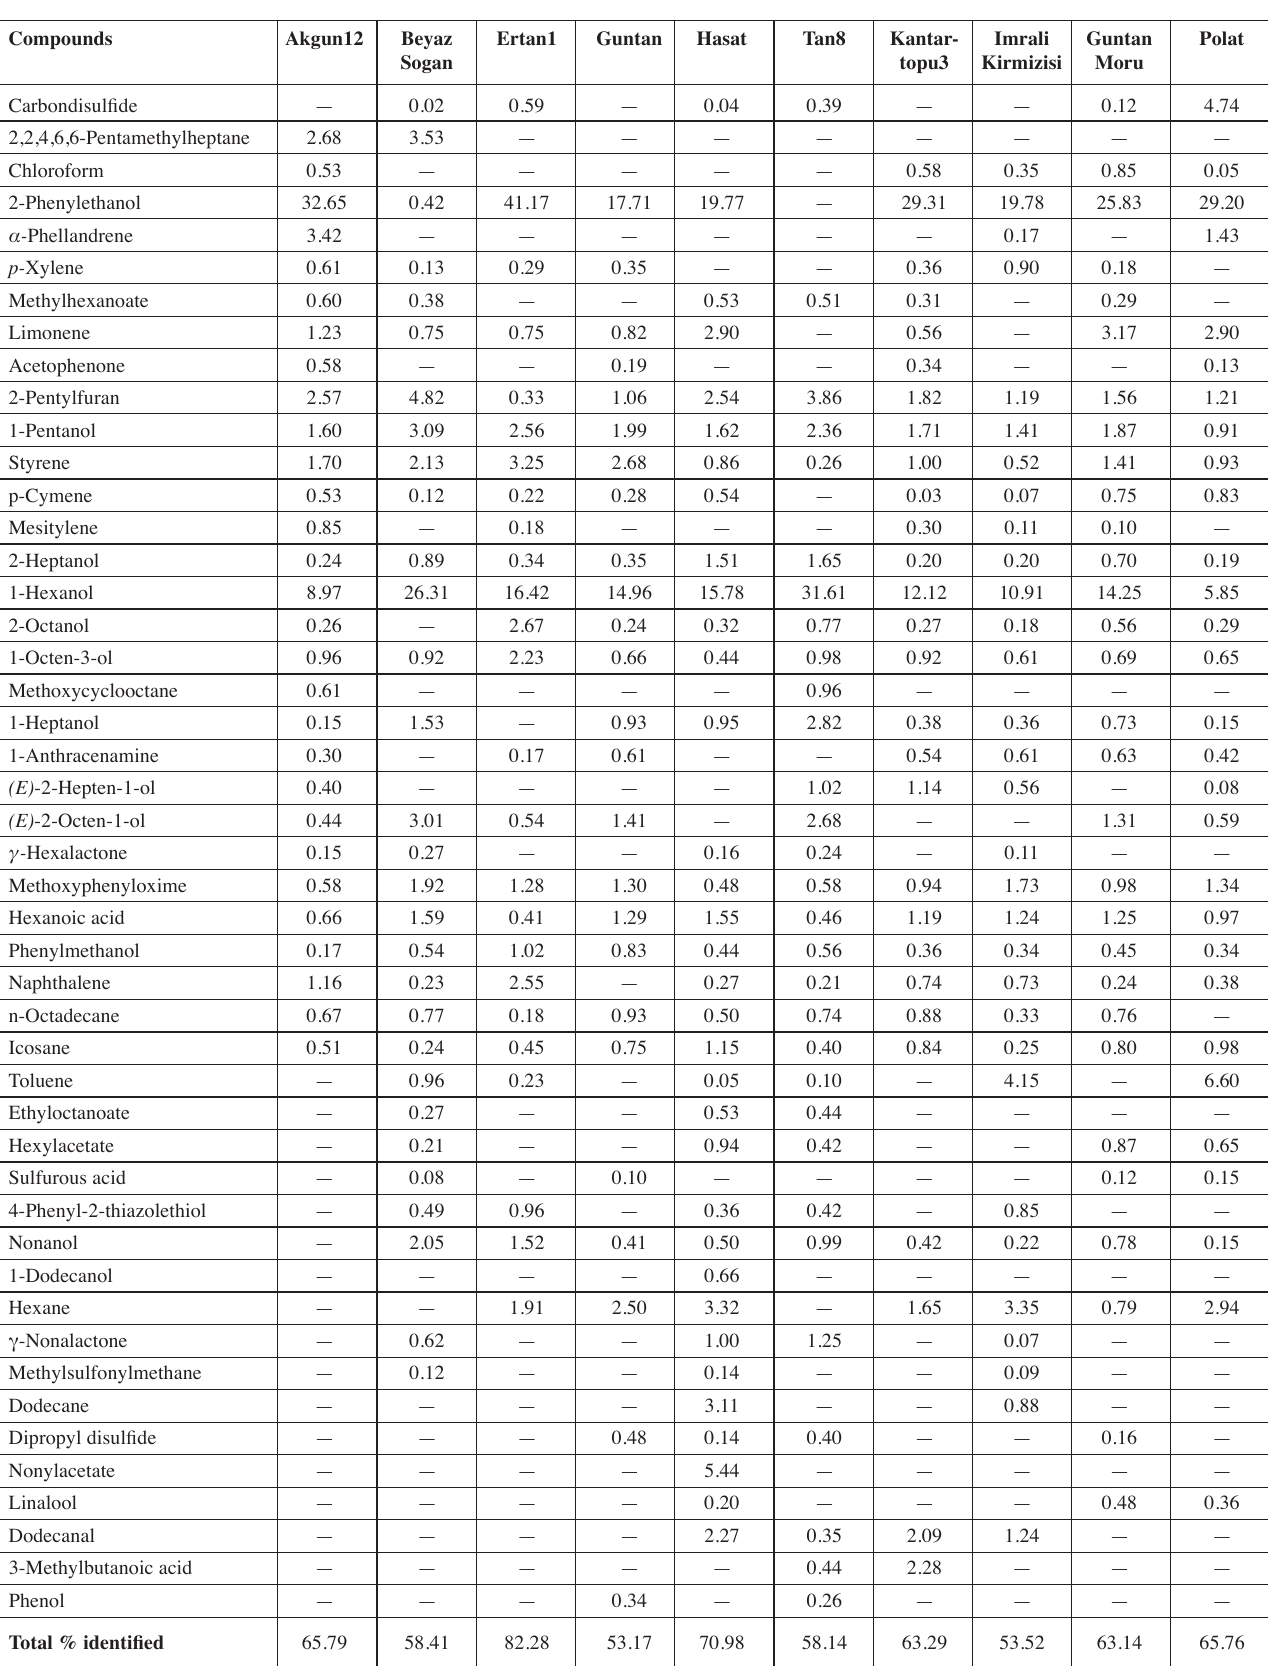
Tab. 4: Volatile components detected in different cultivars of onion seed oils